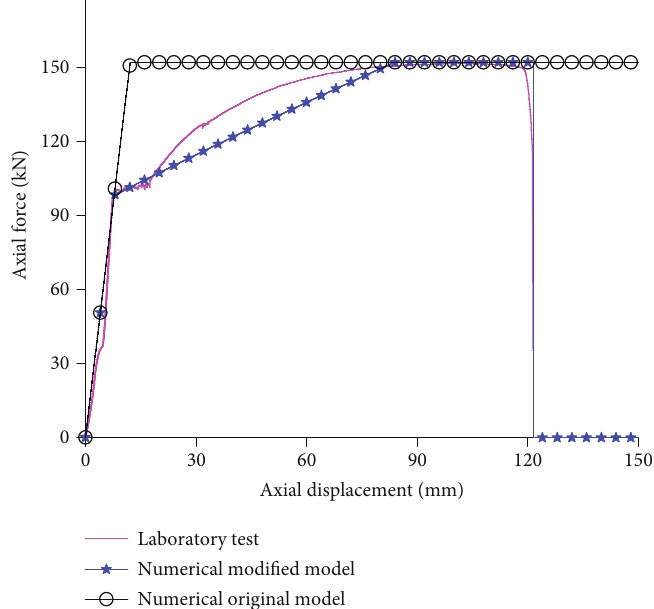
Figure 8: Comparison of the curves of rock bolt load displacement with and without FISH